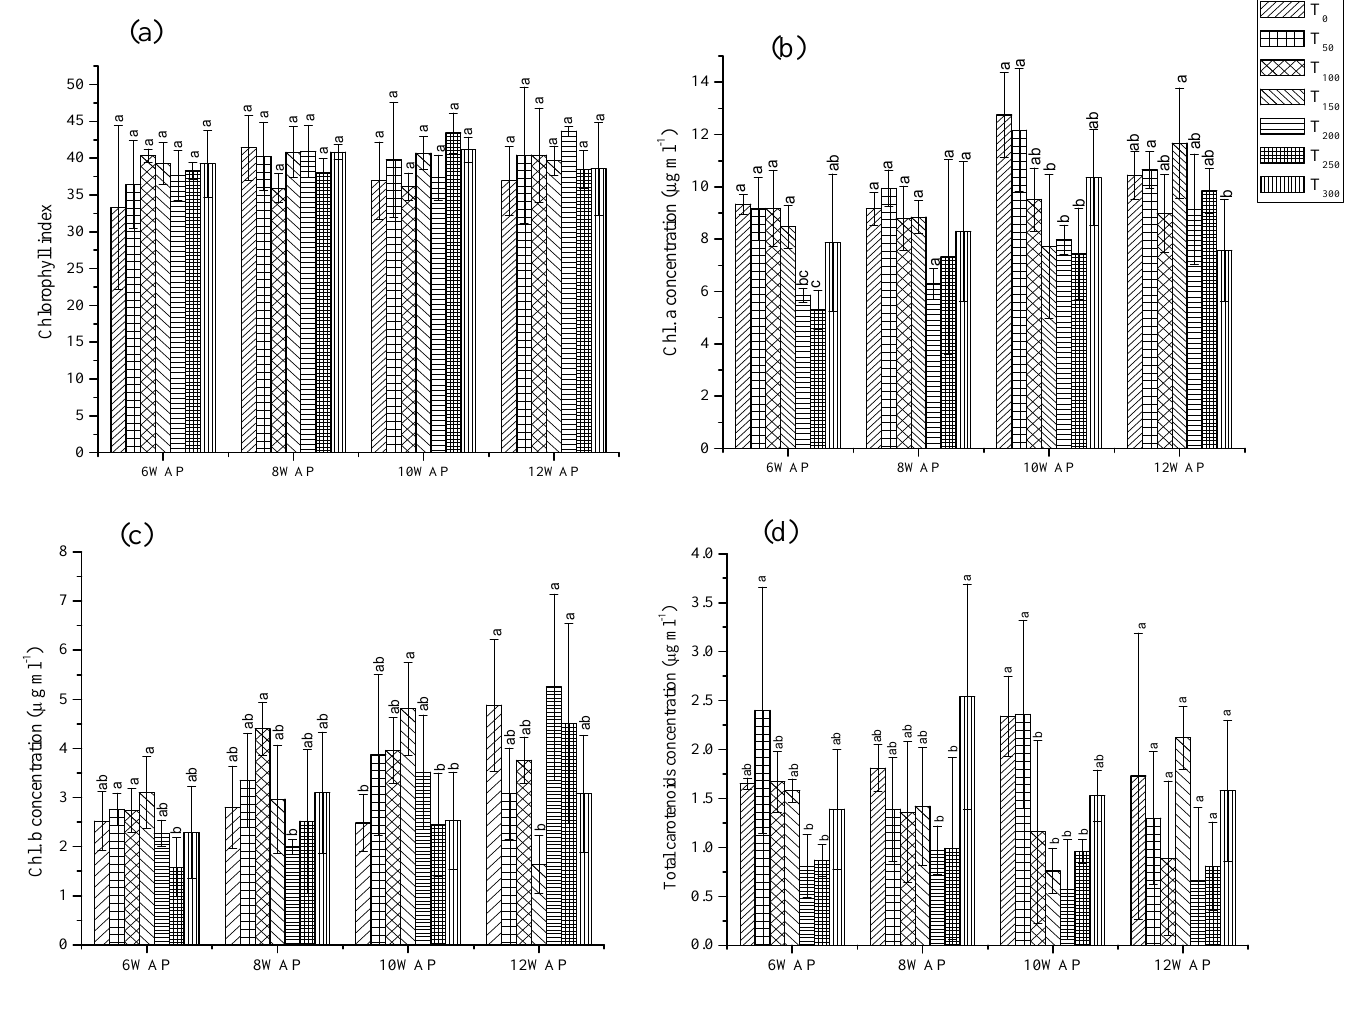
Figure. 2: (a) Chlorophyll index (b) chlorophyll a (c) chlorophyll b and (d) total carotenoids concentrations in C. aciculatus grown in soils contaminated with different concentrations of